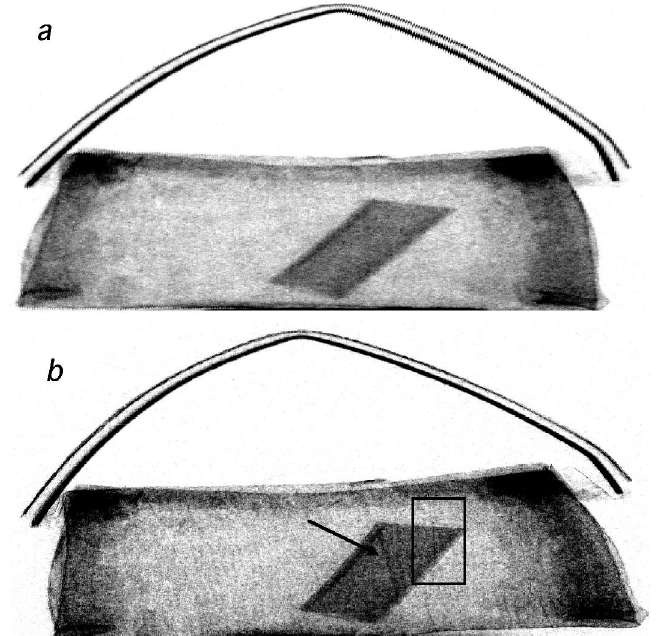
Figure 10. XPCi ( b ) vs. conventional ( a ) images of the second custom test object. An arrow underlines the presence of the thick (300 µm) wire. The area used to obtain the image in Figure 10 is highlighted by a